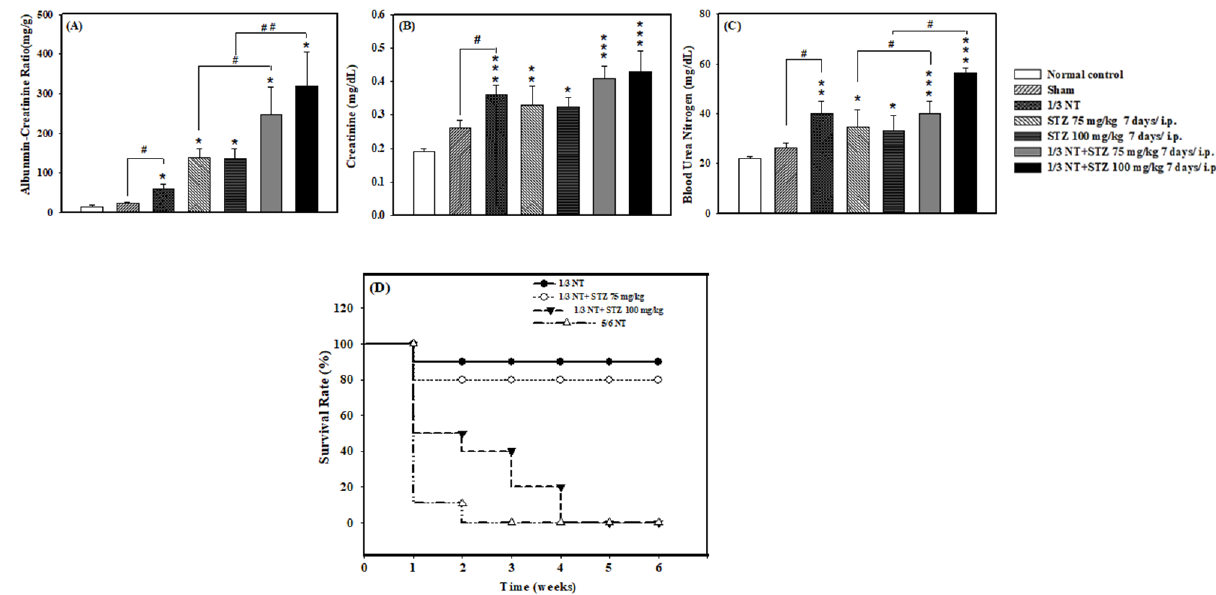
Figure 3. Renal function analysis of mouse models of chronic renal failure. ( A ) Urine albumin-creatinine ratio (ACR), ( B ) Creatinine blood test, ( C ) Blood Urea Nitrogen (BUN), and ( D ) Survival rates were detected in the animal model of chronic renal failure. Normal: native control; Sham: vehicle control; 1/3 NT: residual 2/3 kidney animal model; 5/6 NT: residual 1/6 kidney animal model. The data are expressed as mean ± SE of five mice. *: p < 0.05, **: p < 0.01 and ***: p < 0.001 as compared with the normal control at two weeks. #: p < 0.05, ##: p < 0.01 and ###: p < 0.001 as compared with STZ alone at the two-week trial.